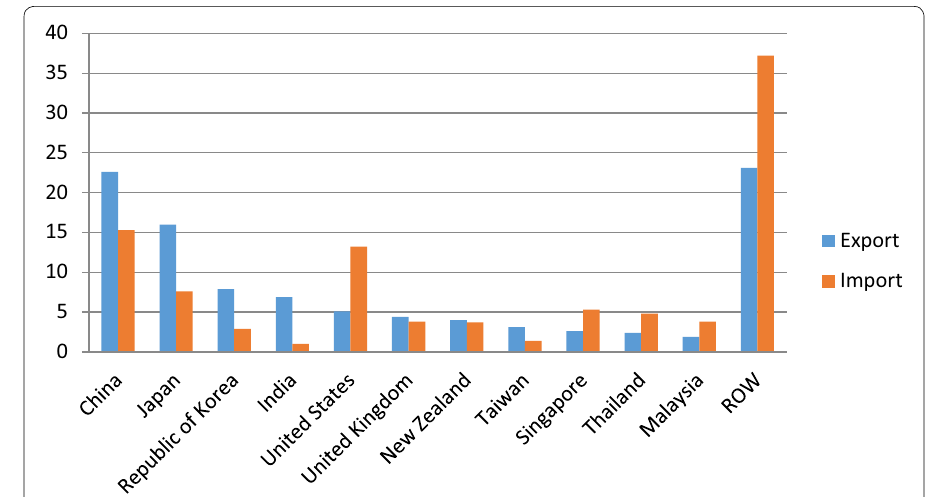
Fig. 2 Export and import shares of Australia’s total trade by trading partner (%). Source Calculated from data obtained from the Department of Foreign Affairs and Trade (DFAT)